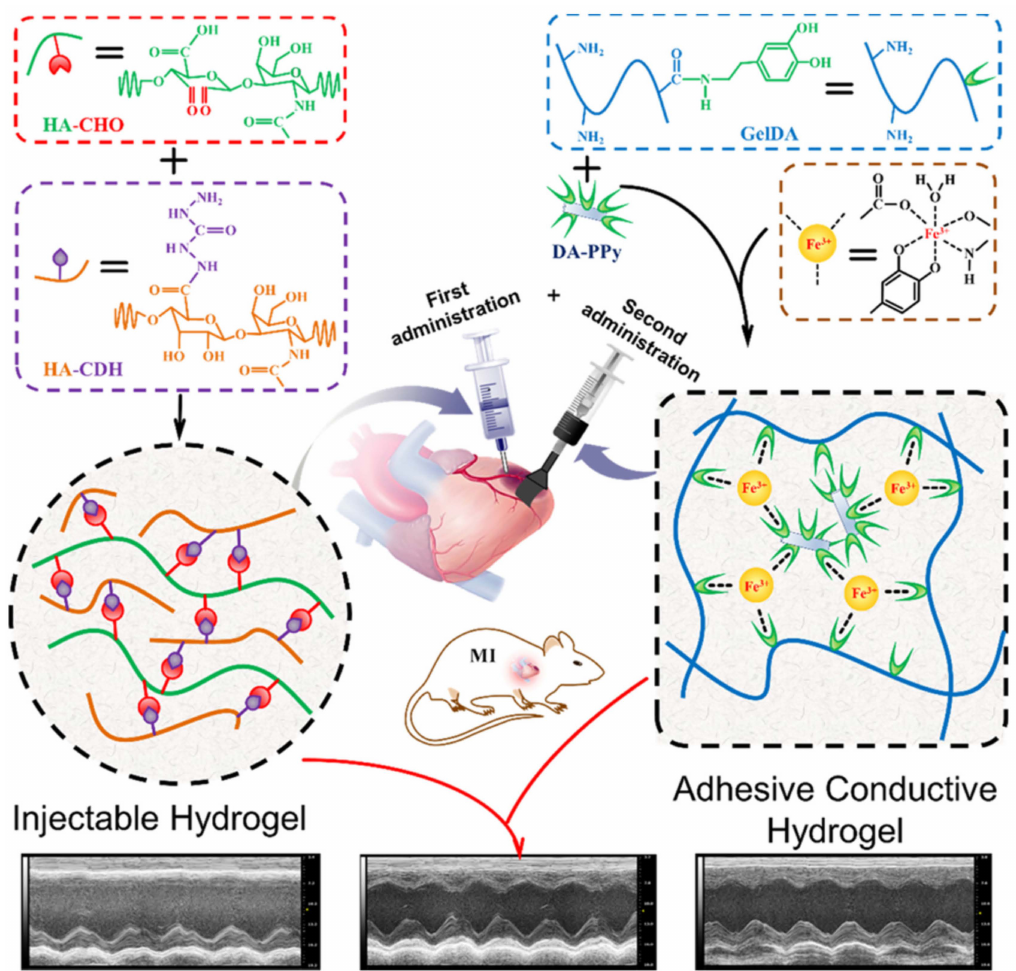
Figure 10. Schematic representation of the treatment of myocardial infarction using the coadministration of the adhesive conductive hydrogel patch and injectable hydrogel. (Reproduced with permission from [81]. Copyright 2019, American Chemical